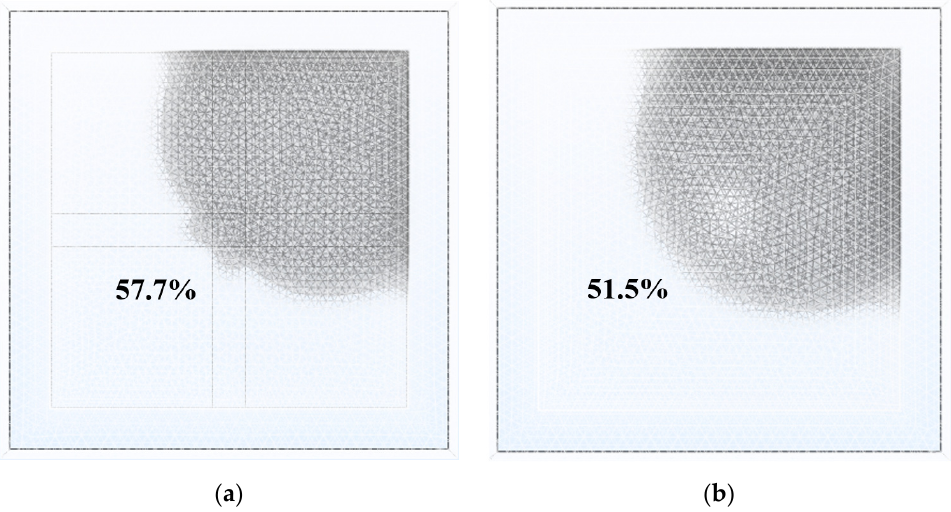
Figure 8. Maximum aperture of the multi-electrode pixel and the single-electrode pixel. ( a ) Top view of oil state when the multi-electrode pixel was fully opened. ( b ) Top view of oil state when the single-electrode pixel was fully opened.